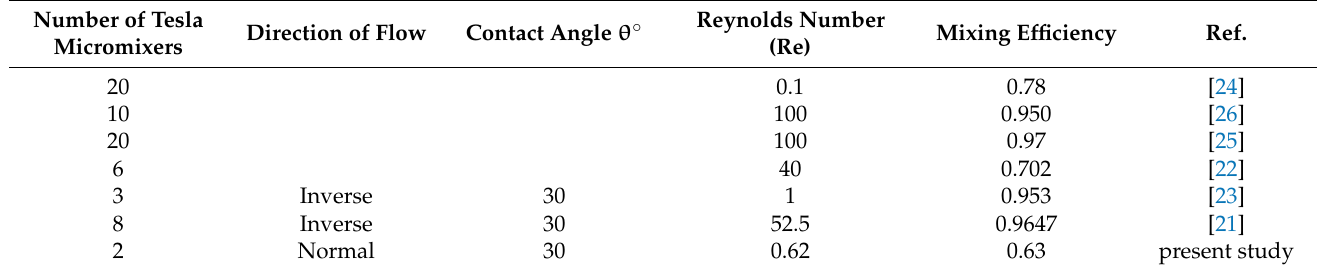
Table 1. Characteristics and mixing efficiency of different Tesla-type